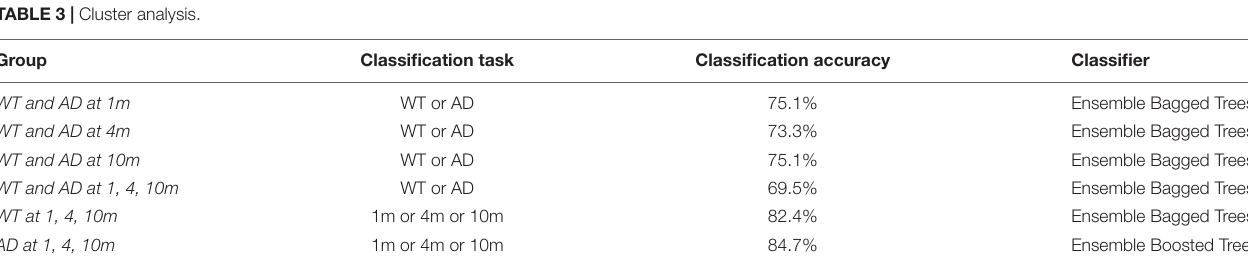
FIGURE 5 | Differences in spike count. (A) Overlap of typical traces for the different conditions. (B) Box plot of number of spikes as a function of somatic current injection. The red symbols in the graphs indicate currents for which the average values were significantly different. * p ≤ 0.05. See full statistical analysis for these features in Supplementary Table 4 . TABLE 3 | Cluster